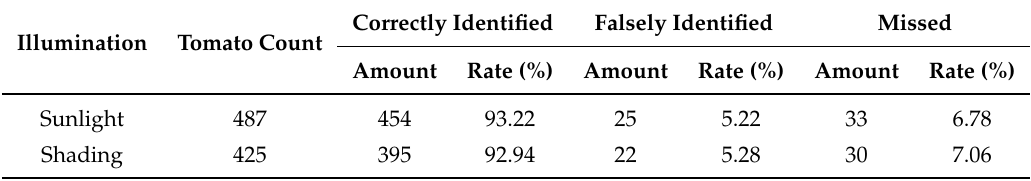
Table 3. The detection results of the proposed method under different lighting